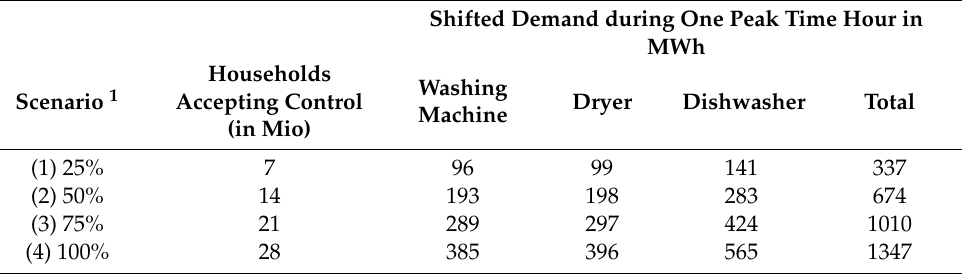
Table 8. Potential shift in electricity demand by